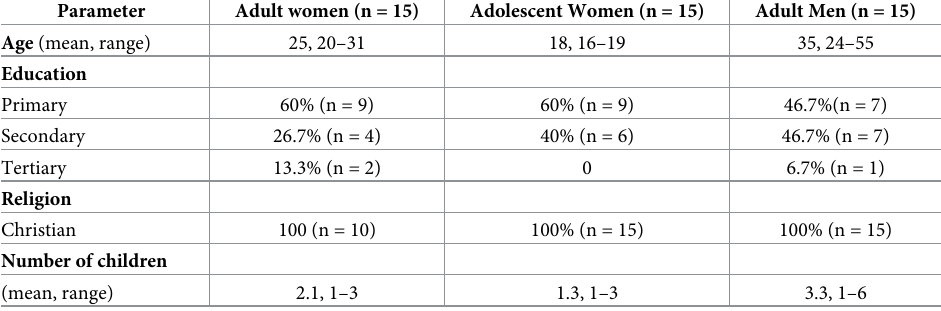
Table 1. Participant